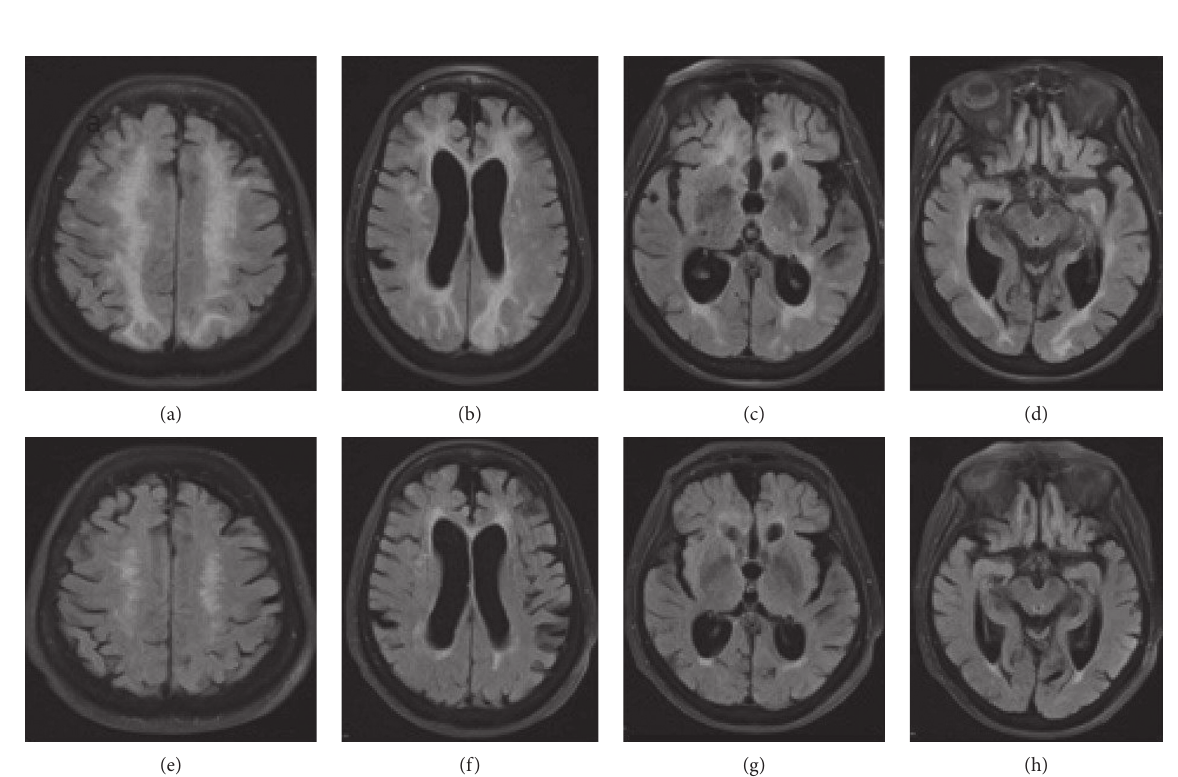
Figure 1: (a–d) Axial FLAIR images at multiple levels demonstrate cortical, subcortical, and periventricular signal hyperintensity and mild mass effect typical of PRES, predominantly involving the bilateral frontal, parietal, and occipital lobes on admission. Follow-up MRI (e–h) images four months after presentation showed resolution of the lesions.